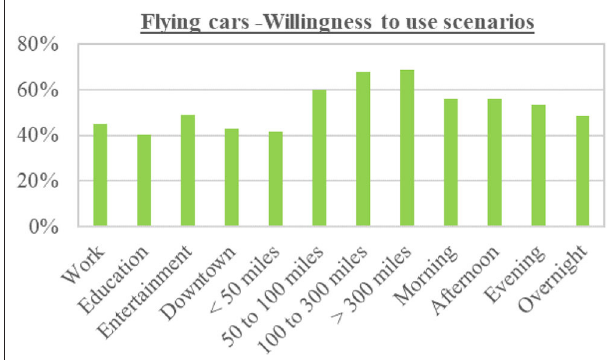
FIGURE 5 | Flying car use case